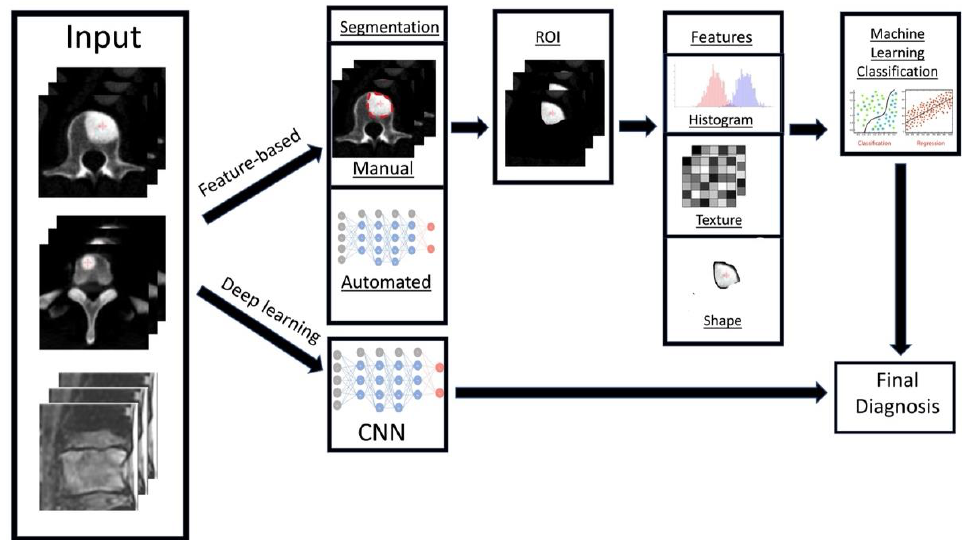
Figure 4. Diagram showing the general framework and main steps for radiomics, namely data selection (input), medical imaging evaluation and segmentation, feature extraction in the regions of interest (ROIs), exploratory analysis and modelling.